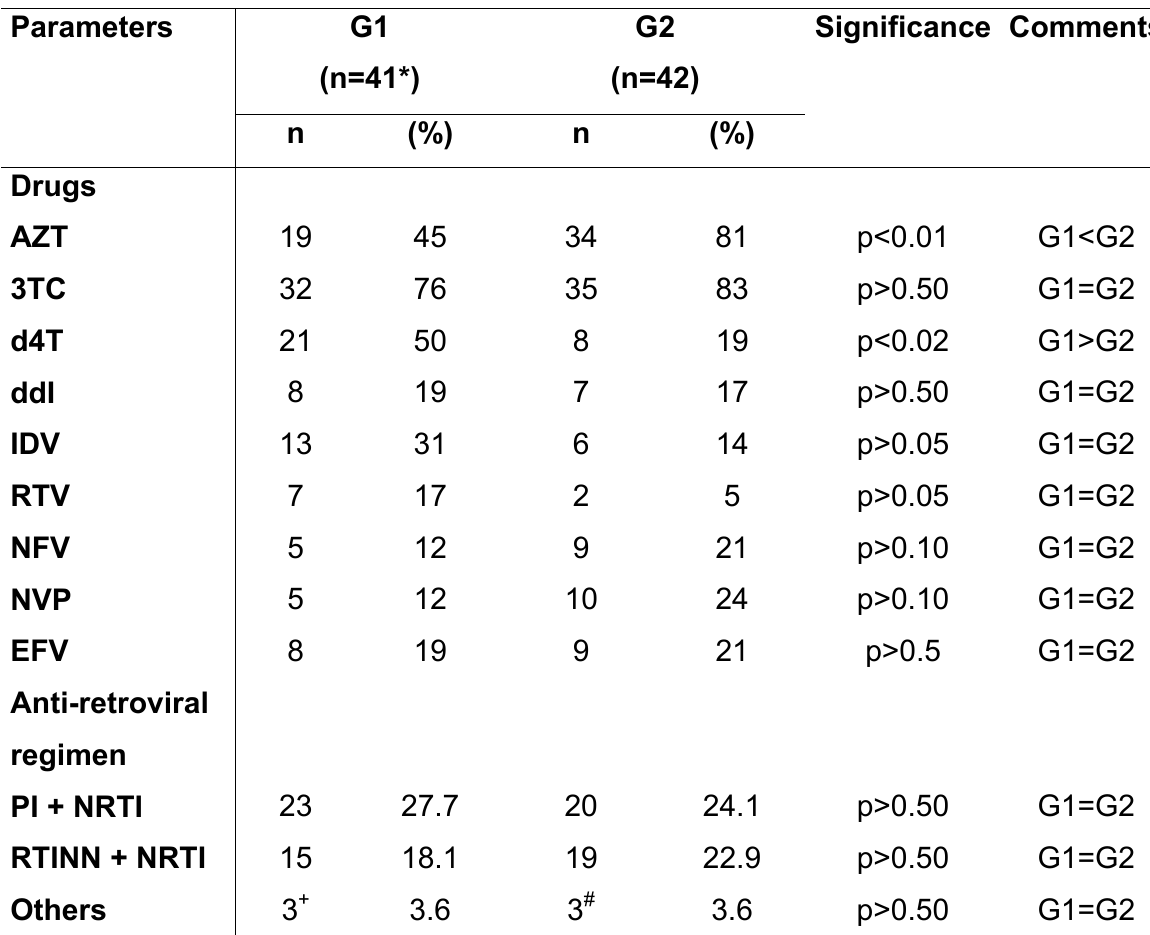
Table 1. Antiretroviral drug and regimen distribution of 83* HIV-1 infected individuals, according to